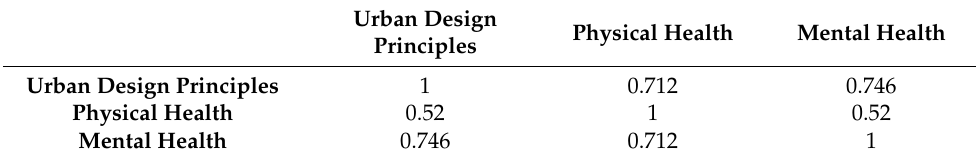
Table 3. Pearson correlation among variables with fit lines.